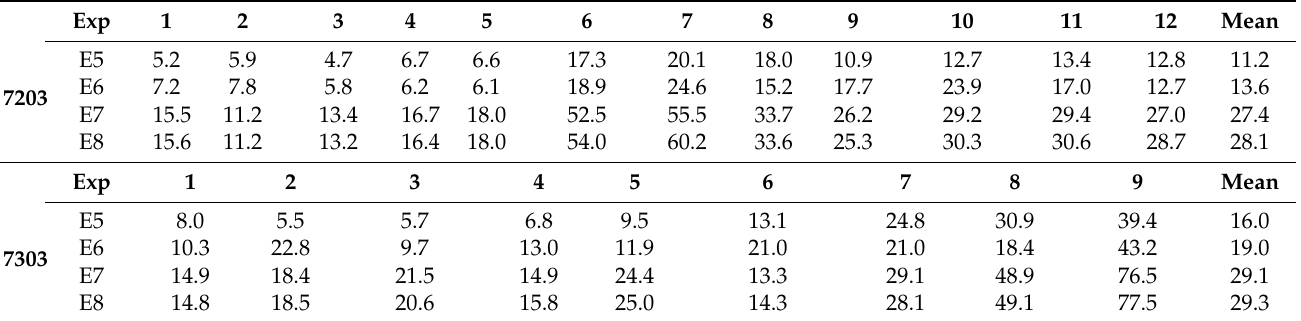
Table 7. Root–mean–square errors between simulated and observed storm surge levels in each 6-hour period during Typhoons 7203 and 7303 (unit: cm).